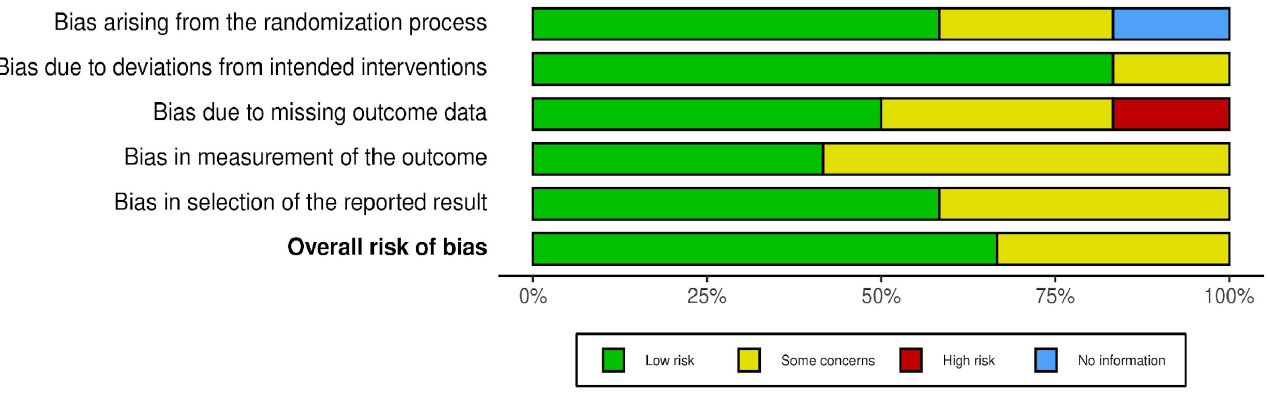
Figure 2. Risk of Figure 2. Risk of bias.